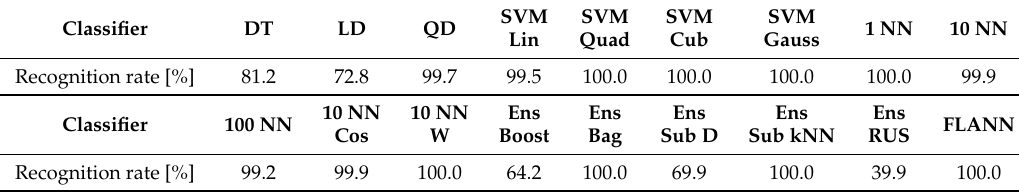
Table 3. 10-fold cross-validation results for dataset 1, configuration (i), variant (a).